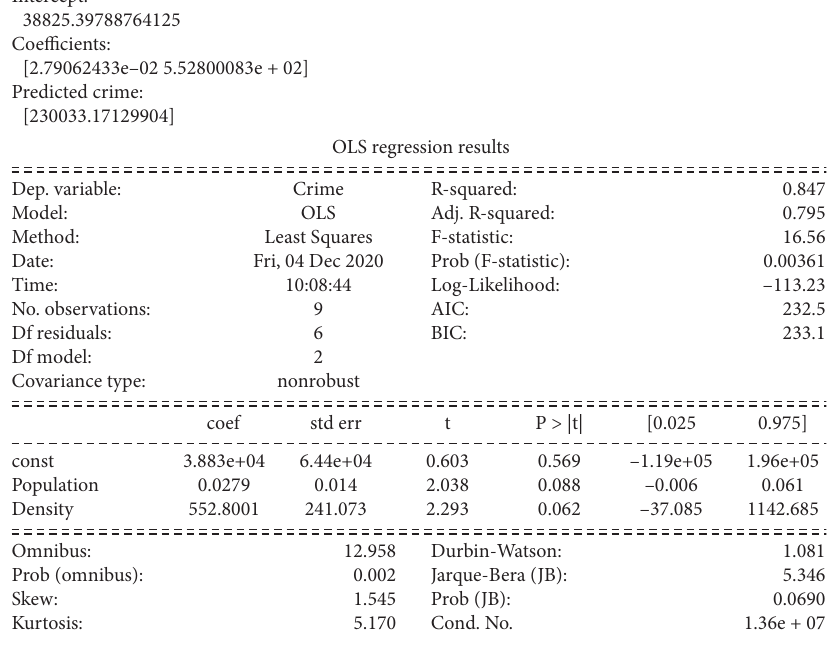
Figure 10: Linear regression